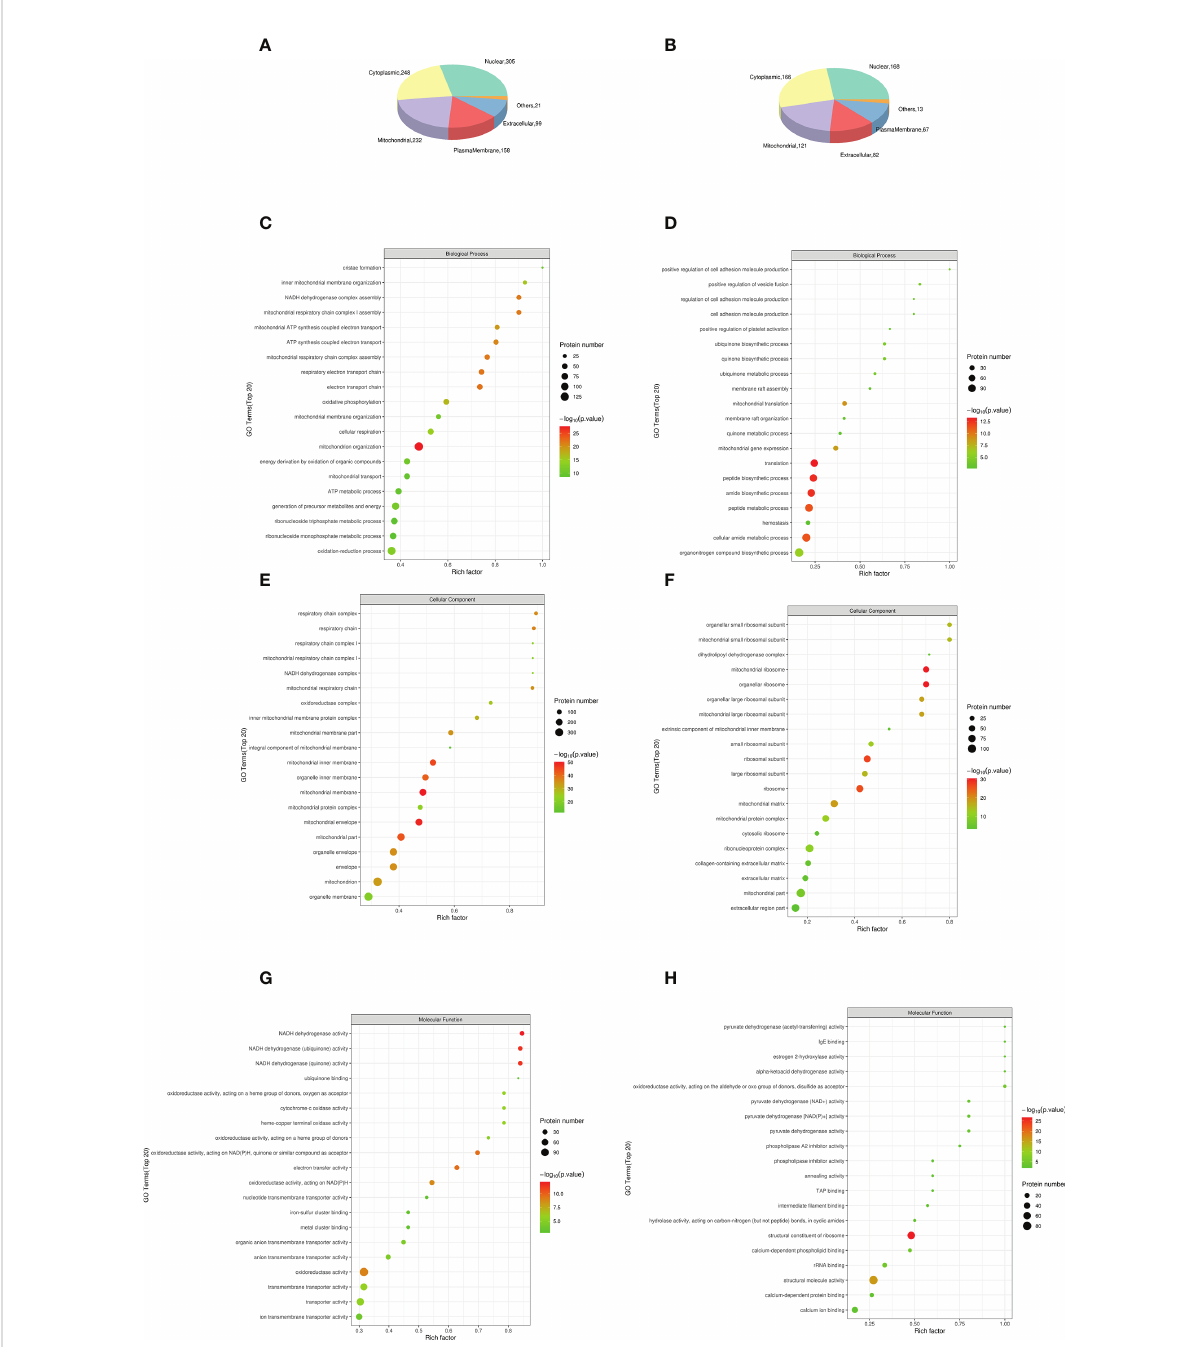
FIGURE 6 The top 15 most signi fi cantly enriched GO terms enriched in DEPs of KD. (A, B) Subcellular localization analysis of differential proteins. (C) Biological process (BP) in NCD/HFD. (D) Biological process (BP) in HFD/Sema. (E) Cellular component (CC) in NCD/HFD. (F) Cellular component (CC) in HFD/Sema. (G) Molecular function (MF) in NCD/HFD. (H) Molecular function (MF) in HFD/Sema.